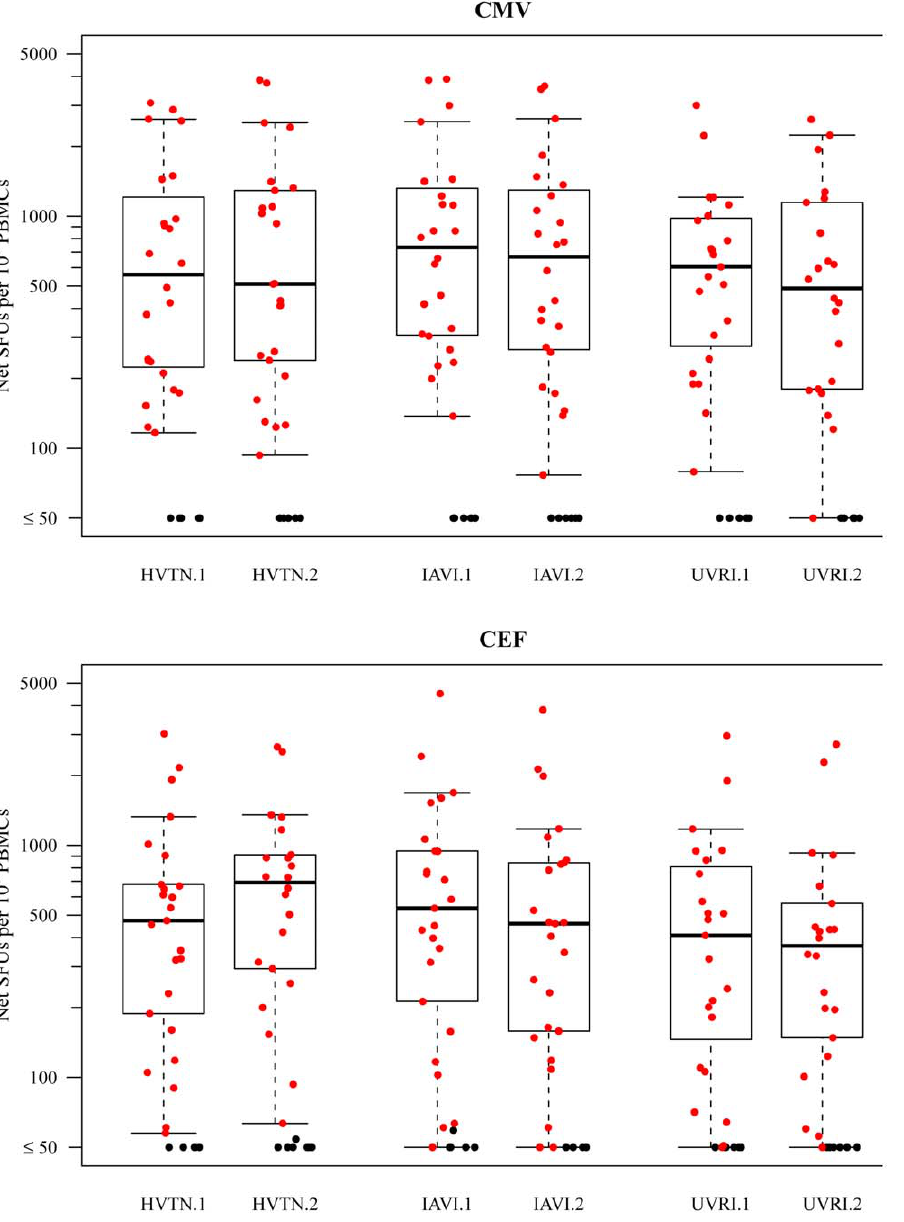
Figure 4. Boxplots of net CMV IFN-g ELISpot responses from the 30 pilot study samples measured in duplicates within each of the 3 laboratories. Inter- and intra-laboratory analysis was performed between the UVRI, IAVI Core laboratory and HVTN laboratory results. 28 of the 30 pilot study samples were also tested by UVRI. Boxes represent the interquartile range of 25–75 th percentile; bars represent the 95 th percentile of IFN-g ELISpot responses. SFU=spot forming units.